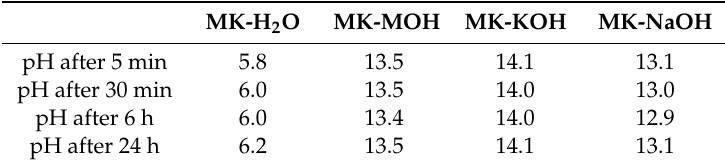
Table 3. Time dependent pH-values of the di ff erent MK